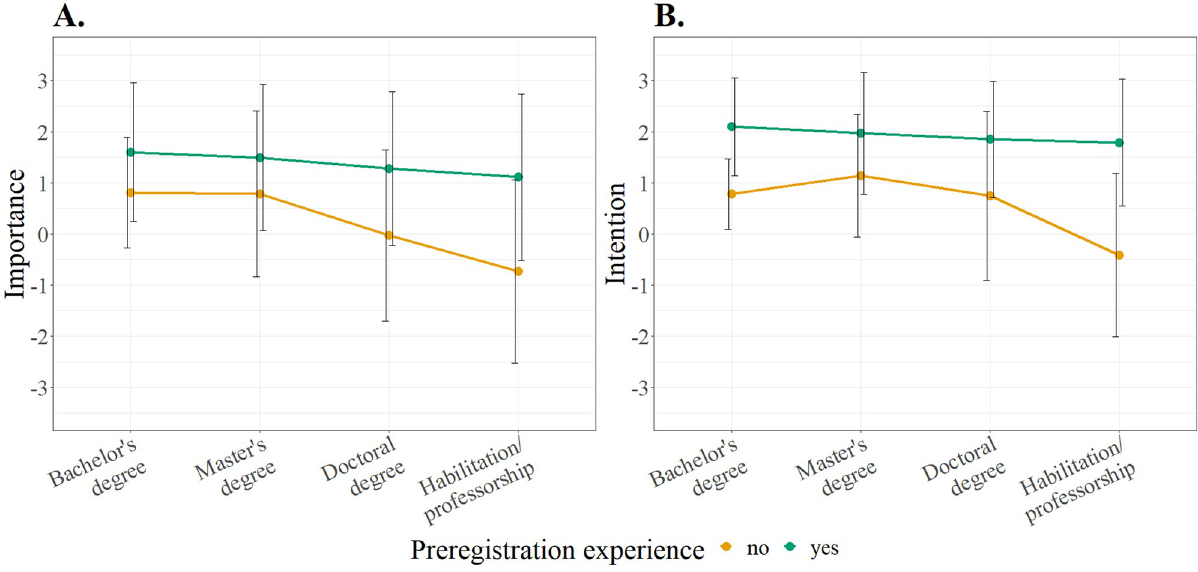
Fig 3. Importance and intention. Mean values for A) the perceived importance of preregistration (one item) and B) participants’ intention to preregister (scale of three items, see S1 Table). Scales ranged from 1 = “Strongly disagree” to 7 = “Strongly agree” and were recoded to “-3 to +3” for data analyses. The error bars show + / − 1 SD